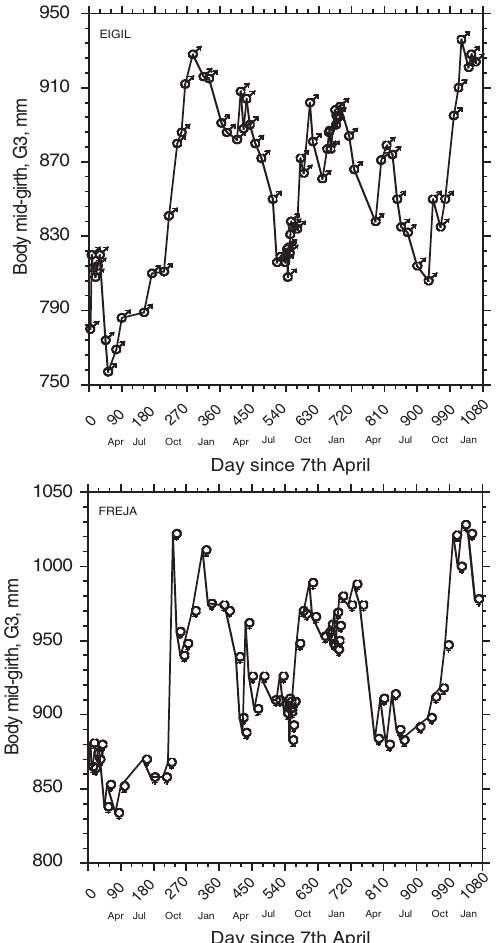
Fig. 7. Seasonal variations in mid body girth G 3 , for Eigil and Freja.